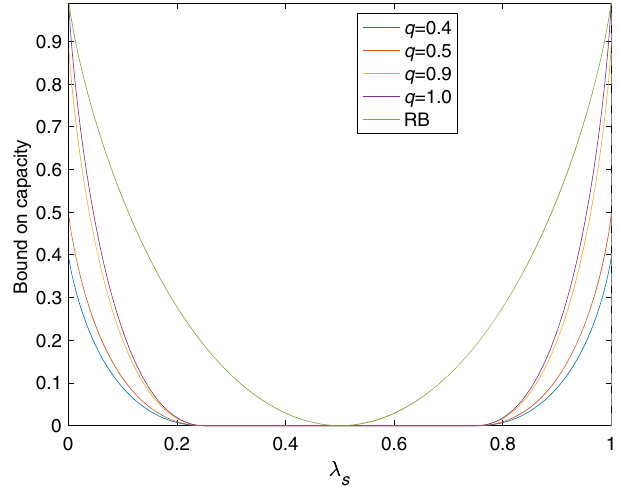
FIG. 8. Upper bounds [Eq. (F5)] on the secret key capacities for the MDI-QKD protocol with dephasing channels for different values of parameters q and λ , in comparison to the RB s bound